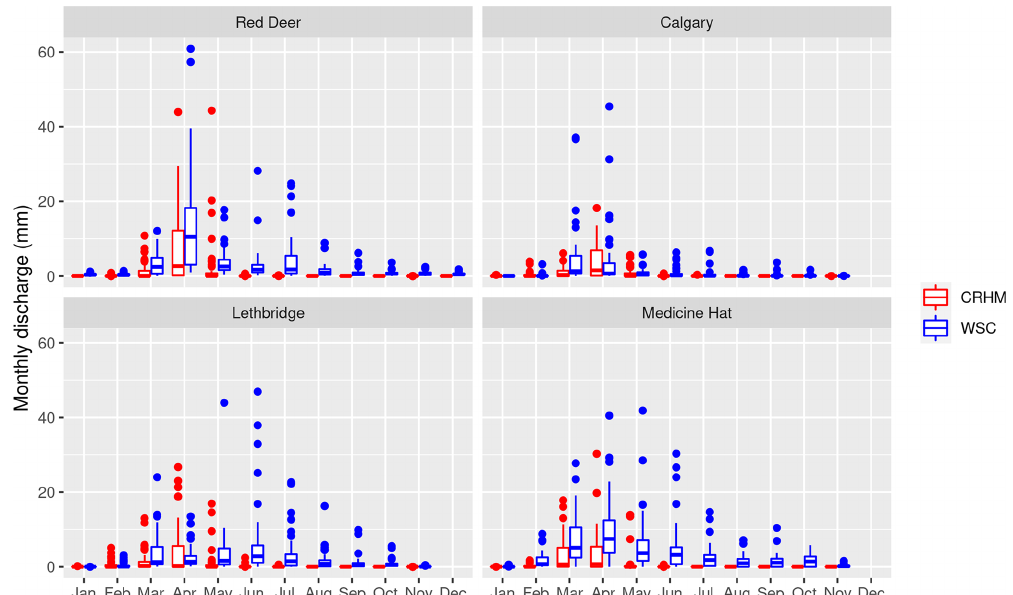
Figure 5. Simulated (CRHM) monthly simulated discharge depths (red) using forcing from four of the climate locations compared with those from WSC gauged streams (blue). The horizontal line in the middle of the box denotes the mean, and the top and bottom of the box denote plus or minus 1 standard deviation. The whiskers denote 10% and 90% percentiles. Circles represent values beyond these